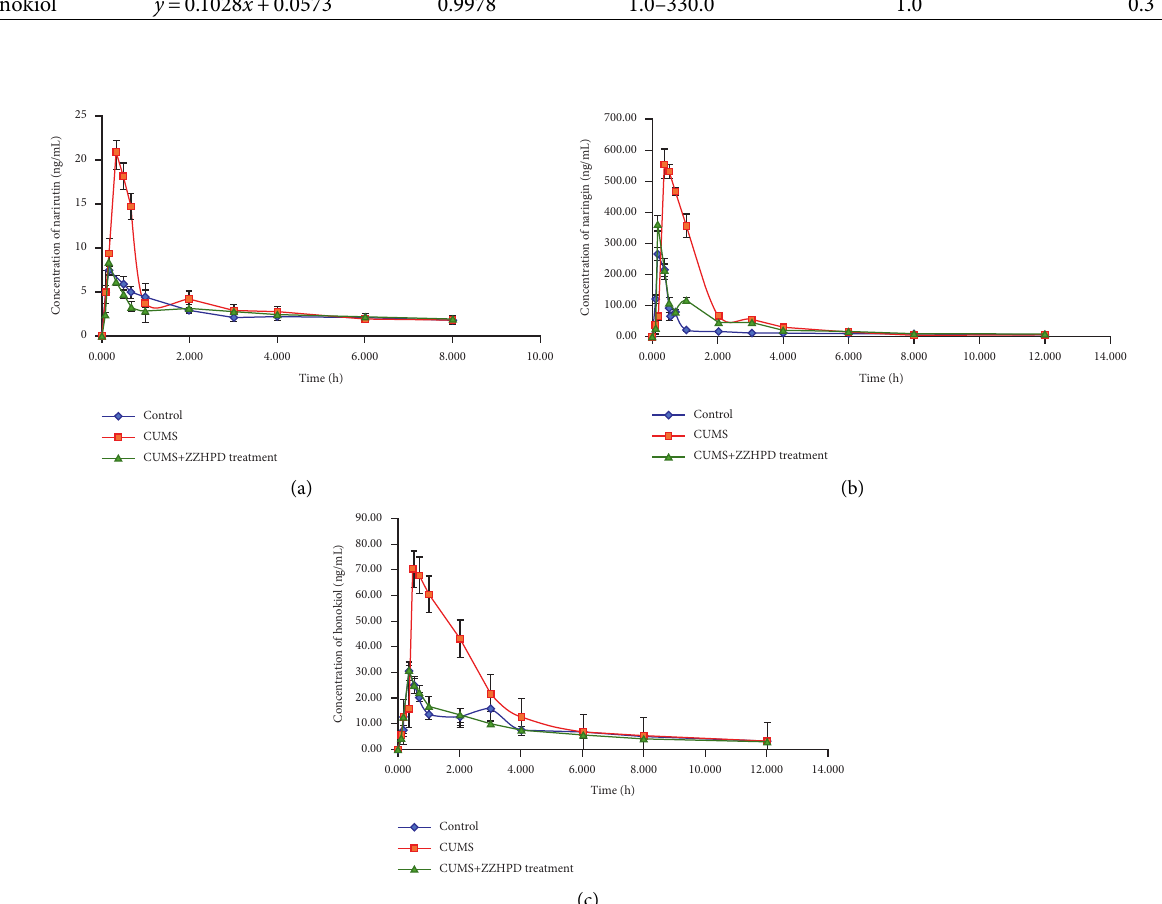
Figure 5: Mean plasma concentration-time profiles of narirutin (a), naringin (b), and honokiol (c) in control, CUMS-induced depression, and CUMS +ZZHPD treatment rats after intragastric administrations of ZZHPD at a dosage of